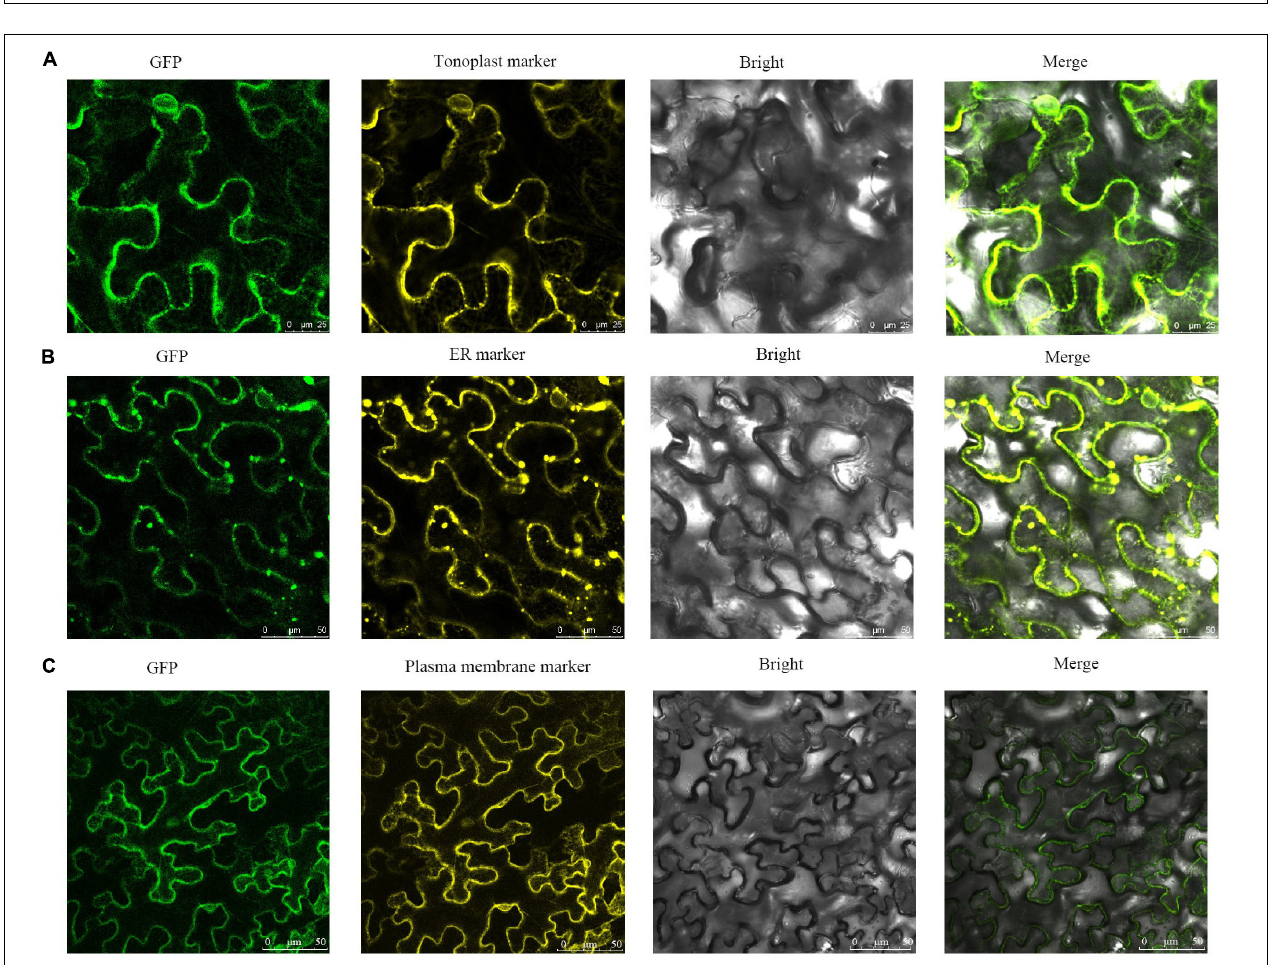
FIGURE 11 | Subcellular localization of SlCCX1-LIKE in the leaves of Nicotiana benthamiana . (A) Tonoplast maker; (B) ER marker; (C) plasma membrane marker.